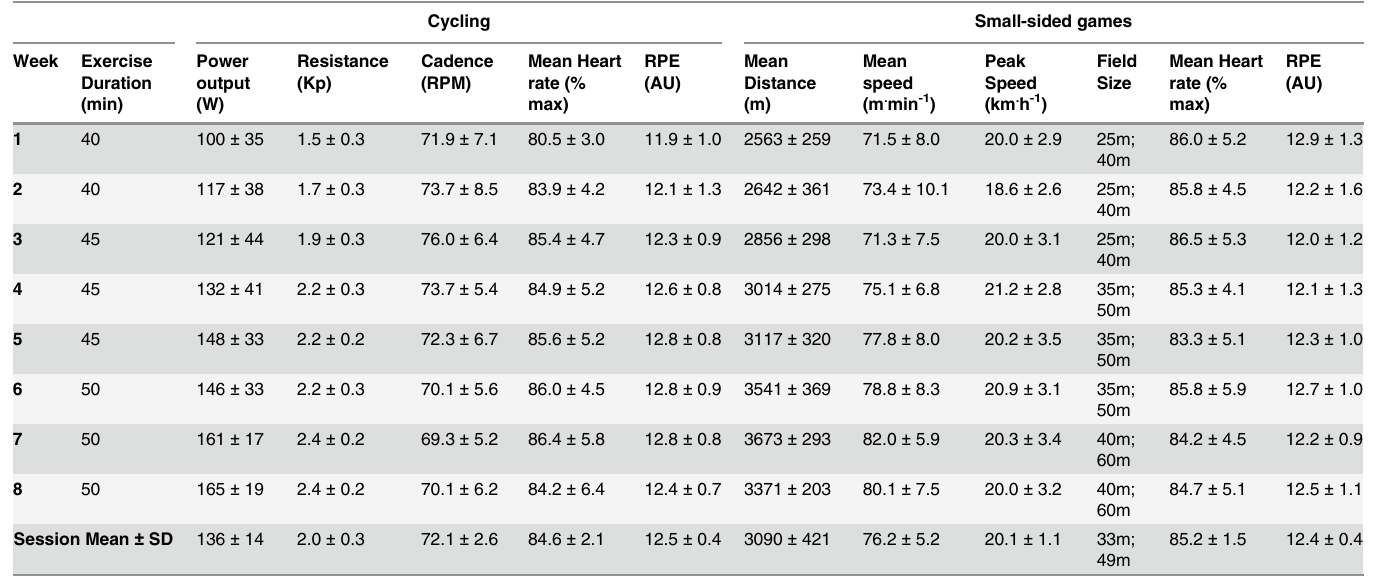
Table 2. Mean ± SD of session training load over 8-weeks within the continuous cycling and small-sided games conditions.